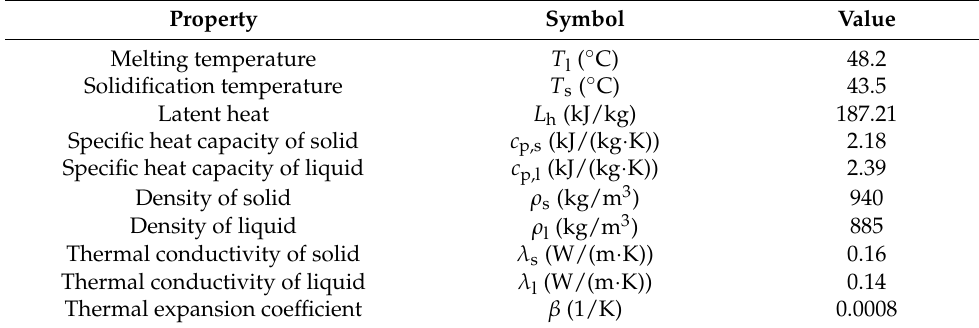
Table 2. Thermo-physical properties of aluminum [27].